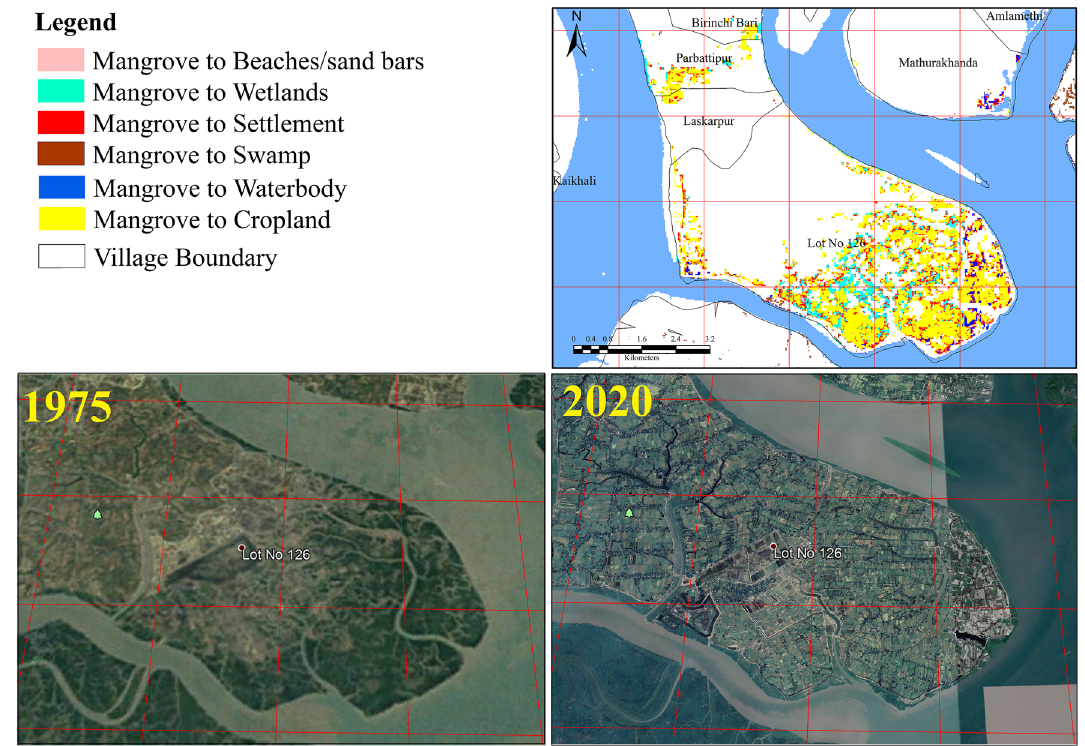
the google earth pro software [https:// www. google. com/ intl/ en_ uk/ earth/ about/ versi ons/]; version 7.3 and EarthExplorer [https:// earth explo rer. usgs. gov/]. The maps were prepared using ERDAS IMAGINE 2014 [https:// hexag on. com/ produ cts/ erdas- imagi ne] and ArcGIS 10.8.2 software [https:// deskt op. arcgis.